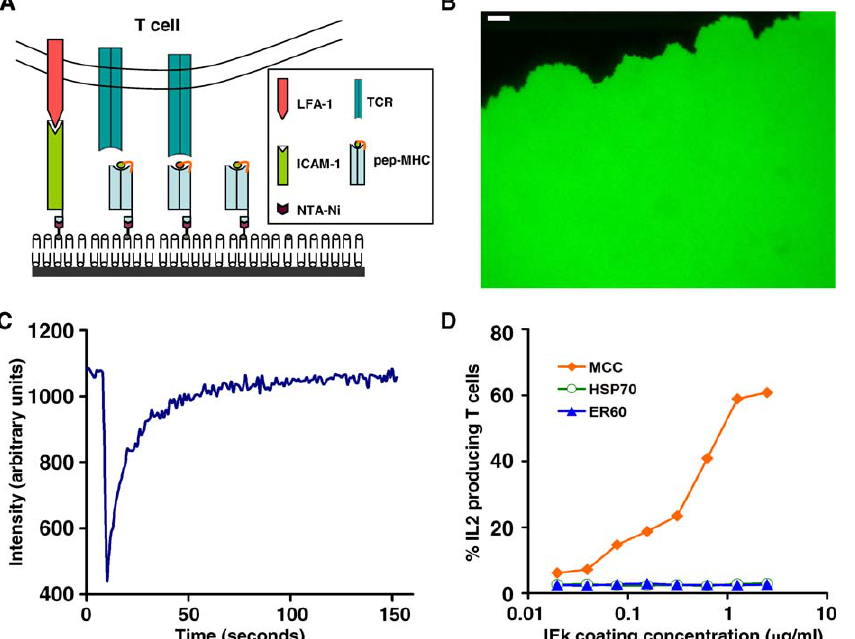
Figure 1. Characterization of the Protein and Lipid Bilayer Components of Artificial APCs (A) Schematic of the interaction between the T cell and the NTA-Ni lipid bilayer-based artificial APC. (B) The expanded area of the POPC bilayer doped with 0.2 mol% fluorescent DOPE-NBD (green). The scale bar represents 10 l m. (C) Fluorescence recovery of a photobleached area ( r ¼ 4 l m) on the POPC/1mol% DOPE-NBD bilayer. (D) Immobilized agonist, but not endogenous pMHC, stimulates AD10 T cells to produce IL2. The 96-well ELISA plates were coated with IEk proteins at the indicated concentrations. AD10 CD4 þ T cells were assayed for IL2 production.